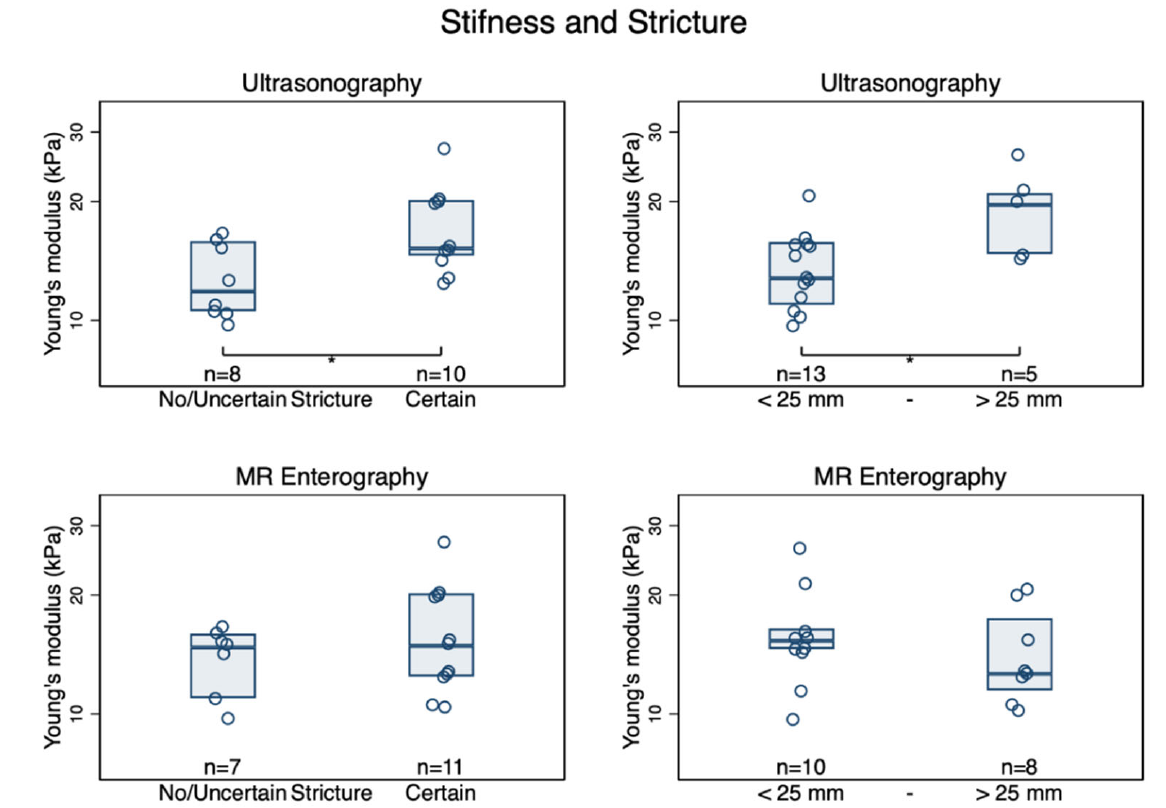
Figure 6. Box plot of circumferential stiffness in small intestinal Crohn’s disease strictures defined as certain vs. no/uncertain by ultrasonography ( top left ) and MR enterography ( bottom left ). When applying definitions of prestenotic dilatation of >25 mm for becoming a certain stricture on ultrasonography ( top right ) and MR Enterography ( bottom right ), Boxes are median and inter- quartile ranges. * p < 0.05.